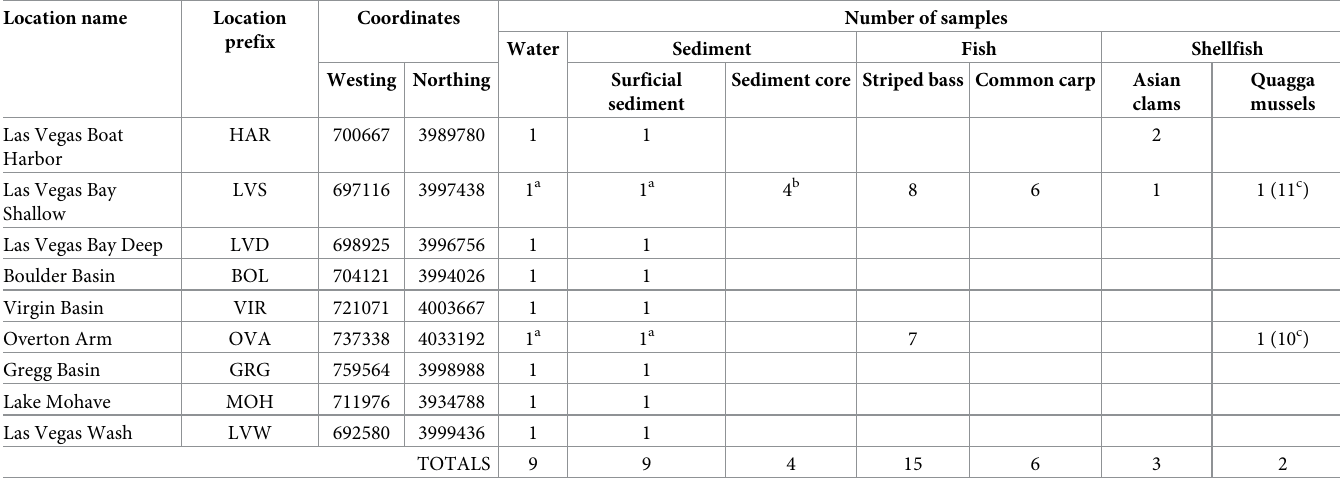
Table 1. Sampling locations and types and numbers of samples